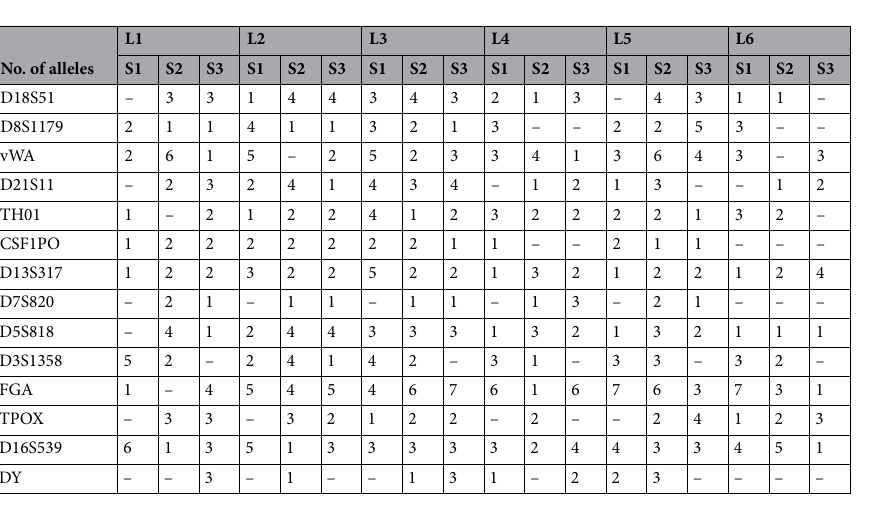
Table 2. Allelic data for the field-collected samples. “S” refers to “sample”; “–” indicated no result.